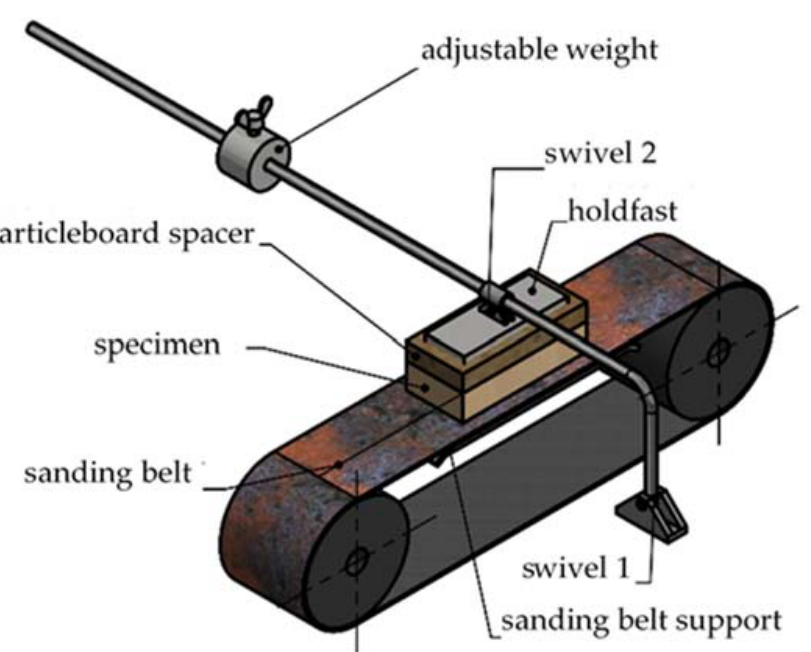
Figure 1. Scheme of the prototype sanding machine used in this work.